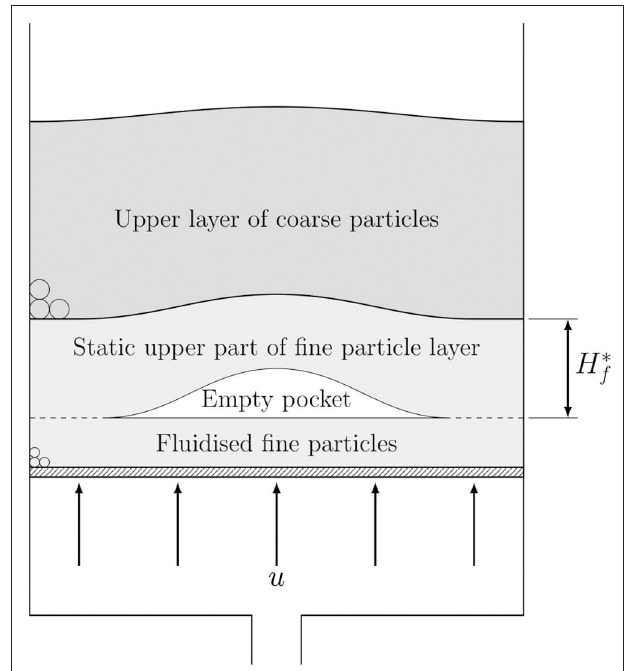
FIGURE 6 | Schematic diagram of a two-layered bed just after activity in the bed has initiated when the weight of the top layer is supported by the effects of fluid